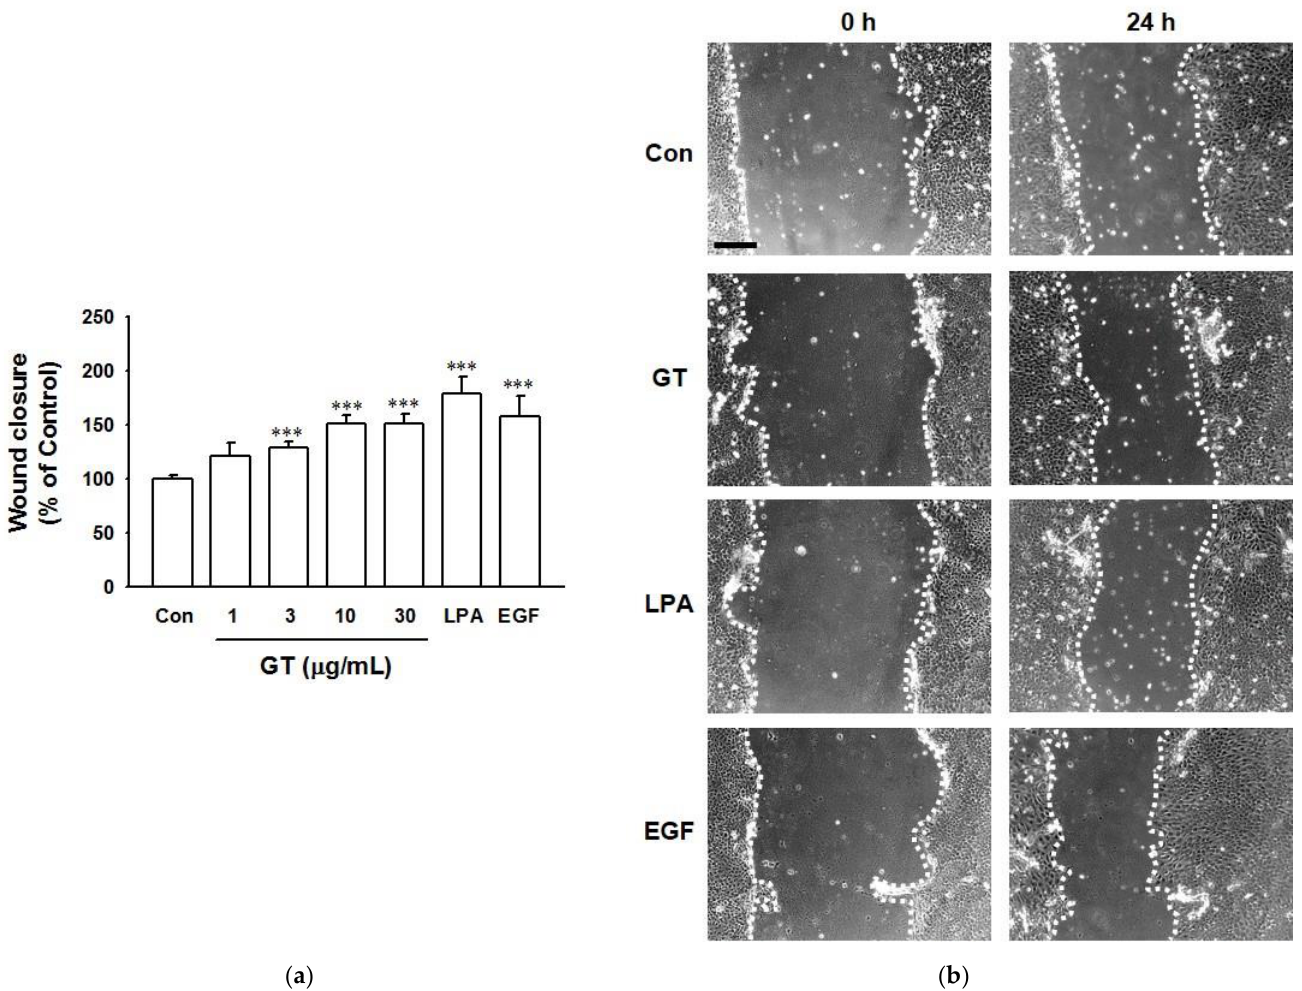
Figure 2. Effects of gintonin on scratch wound healing of HaCaT cells. ( a ) Cells were serum-starved for 24 h. The cell layer was scratched with a micropipette tip to make a wound and then incubated with serum-free medium for 24 h containing gintonin (GT; 1–30 µ g/mL), lysophosphatidic acid (LPA, 10 µ M), or epidermal growth factor (EGF, 4 ng/mL). Photos were taken at 0 h and 24 h after treatment with GT, LPA, or EGF. ( b ) Representative images of untreated control cells and cells treated gintonin (10 µ g/mL). Each cell-free area was outlined with a white dotted line. Scale bar is equivalent to 200 µ m. LPA and EGF were used as positive controls. Response of untreated cells (Con) was considered as 100%. Data are presented as the means ± S.E.M. ( n = 9); *** p < 0.001 vs. untreated cells.